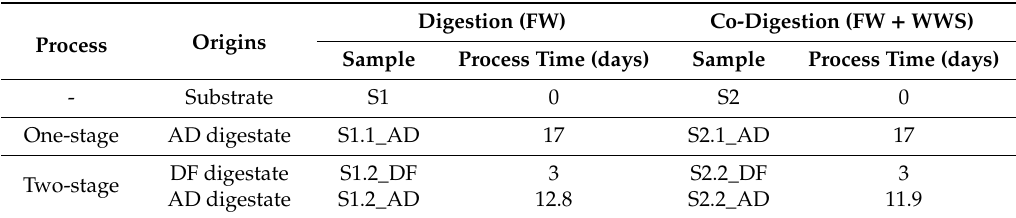
Table 1. Feedstocks and digestates samples studied. Process time depends on the operational condition, which is based on maintaining an organic loading rate (OLR) in the anaerobic digestion (AD) reactor, equal to 2.5 kgTVS/m 3 × d, as defined in the study of Baldi et al. [21].